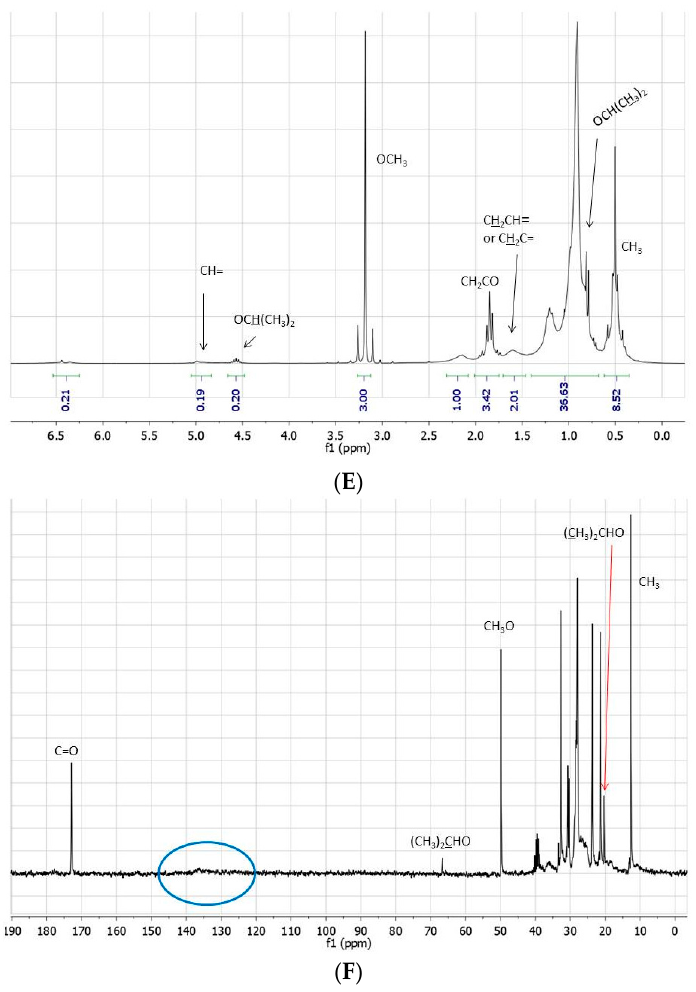
Figure 1. ( A ) 1 H- and ( B ) 13 C - NMR spectra (neat, DMSO- d 6 in coaxial tube) of methyl linoleate; ( C ) 1 H- and ( D ) 13 C - NMR spectra (neat, DMSO- d 6 in coaxial tube) of the product mixture arising from the reaction of methyl linoleate with propene in [bmim][Tf 2 N]/Al(Tf 2 N) 3 at 100 °C for 72 h; ( E ) 1 H- and ( F ) 13 C-NMR spectra (neat, DMSO- d 6 in coaxial tube) of the product mixture arising from the reaction of methyl linoleate with propene in at 100 °C [bmim][GaCl 4 /Ga 2 Cl 7 for 8 h. The blue circles evidence the region of the double bond carbons.